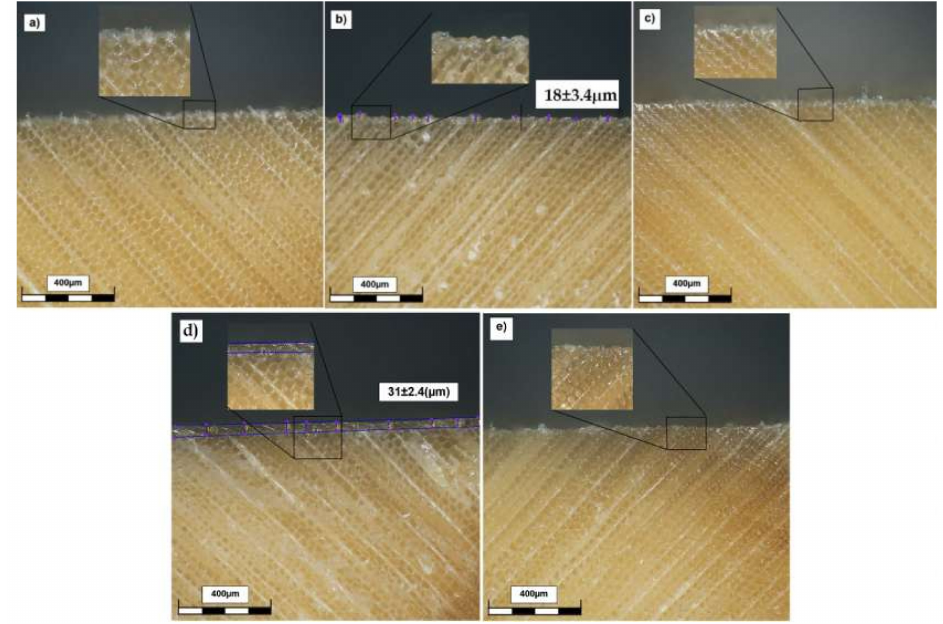
Figure 12. Cross-section micrographs obtained by optical profilometry to illustrate the cross-section profile of the wood samples: ( a ) untreated; ( b ) 5%-brushing; ( c ) 5%-immersion; ( d ) 10%-brushing; and ( e )